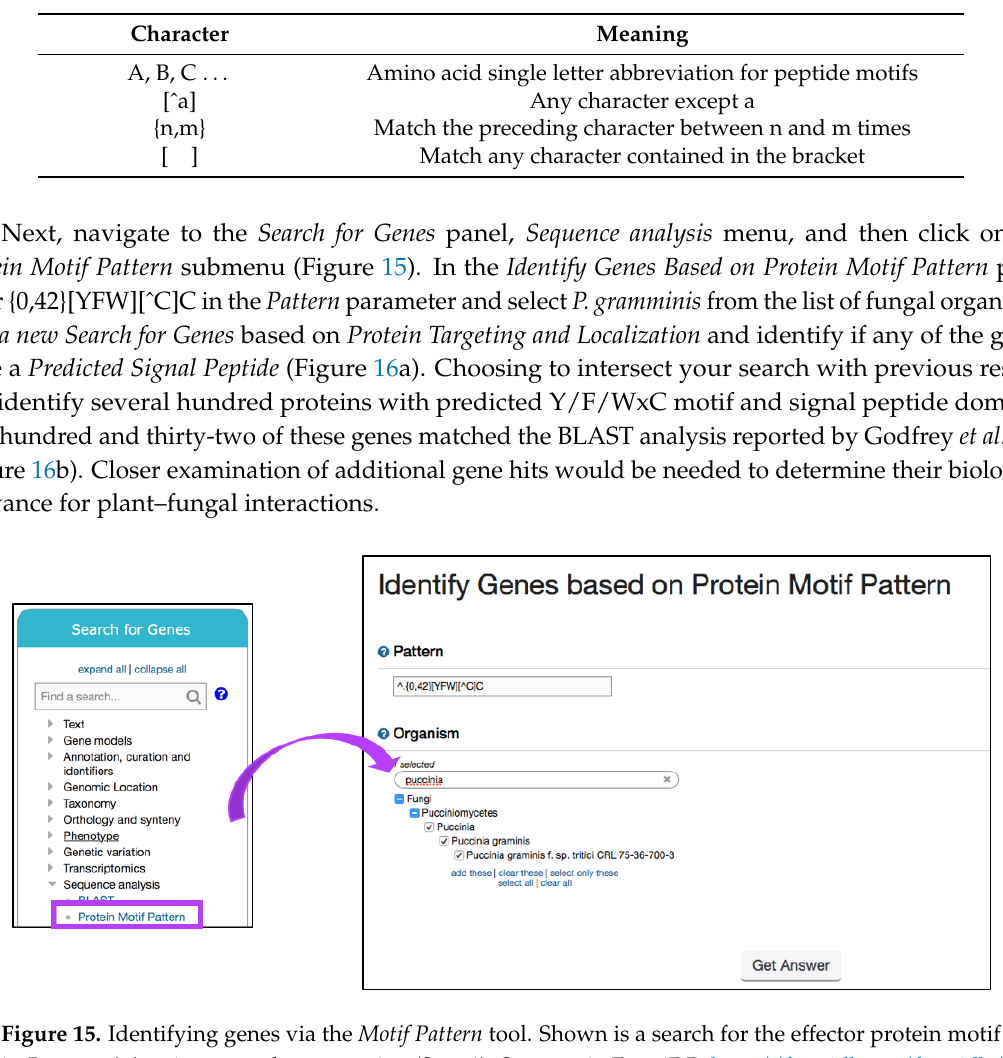
Table 1. Examples of special characters used in Perl-style regular expressions.